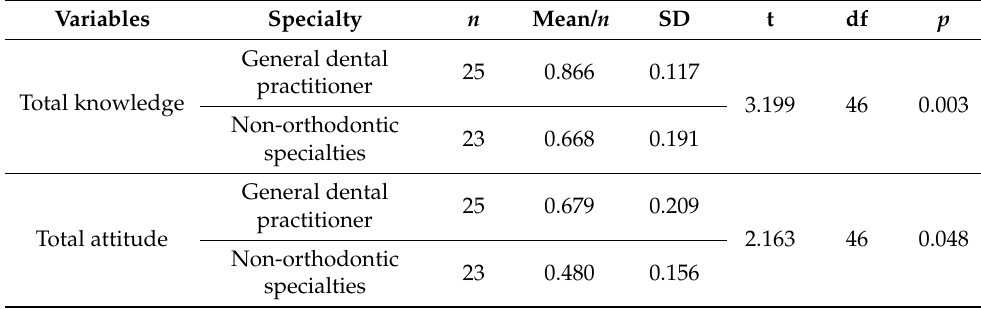
Table 6. Comparison of knowledge and attitude among practitioners classification ( n =